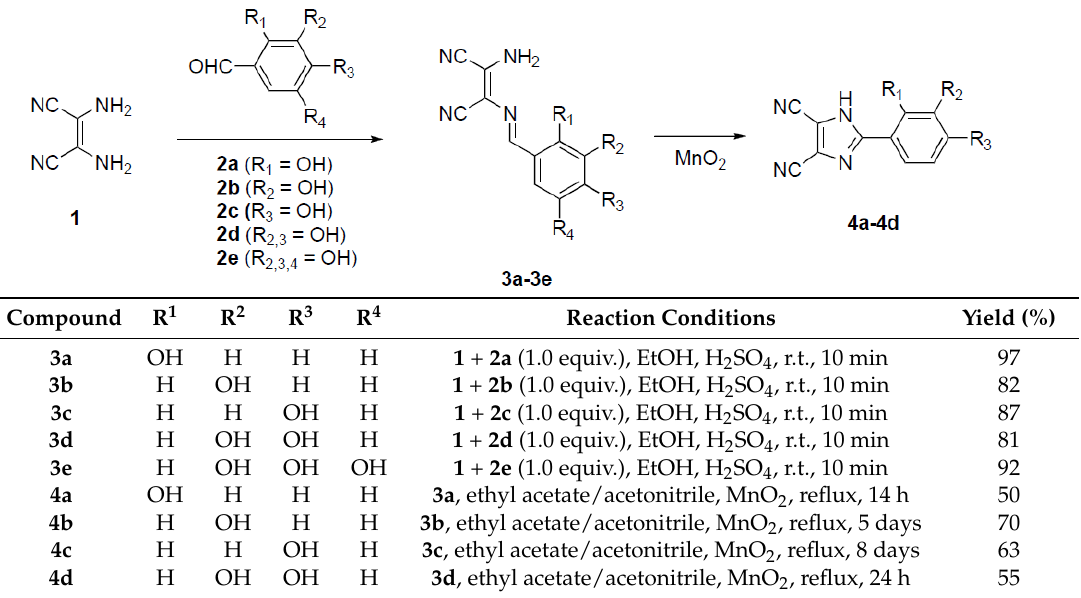
Table 1. Experimental conditions for the synthesis of target compounds 3 and 4 .